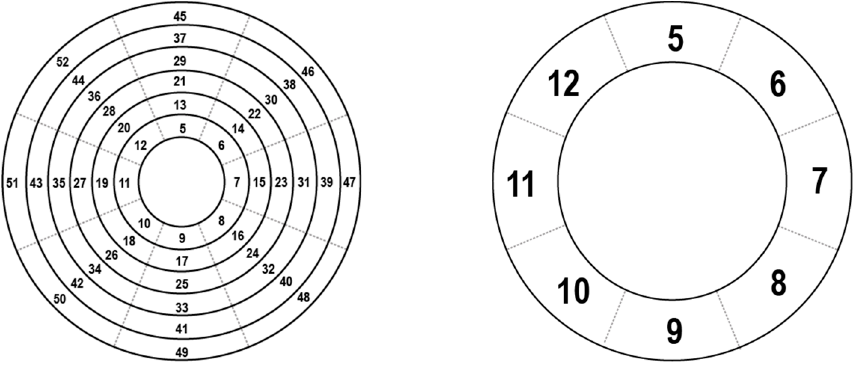
Figure 2. All antenna clusters ( left ) and a single antenna cluster ( right ).